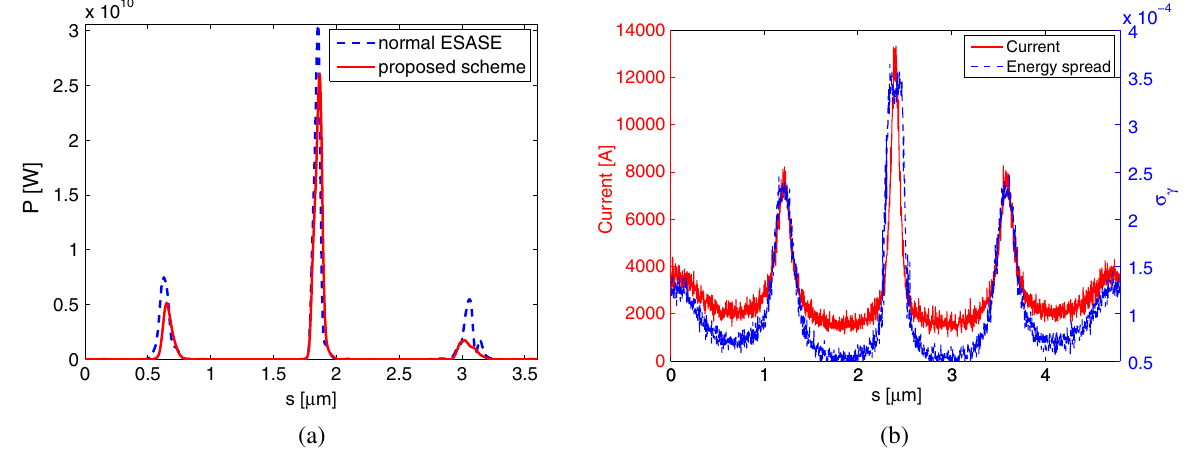
FIG. 8. (a) Radiation power for our proposed scheme at 40 m (red solid line) and for the normal ESASE technique at 35 m (blue dashed line). (b) Current profile (red solid line) and slice energy spread (blue dashed line) at the entrance of the radiator section for the normal ESASE technique.